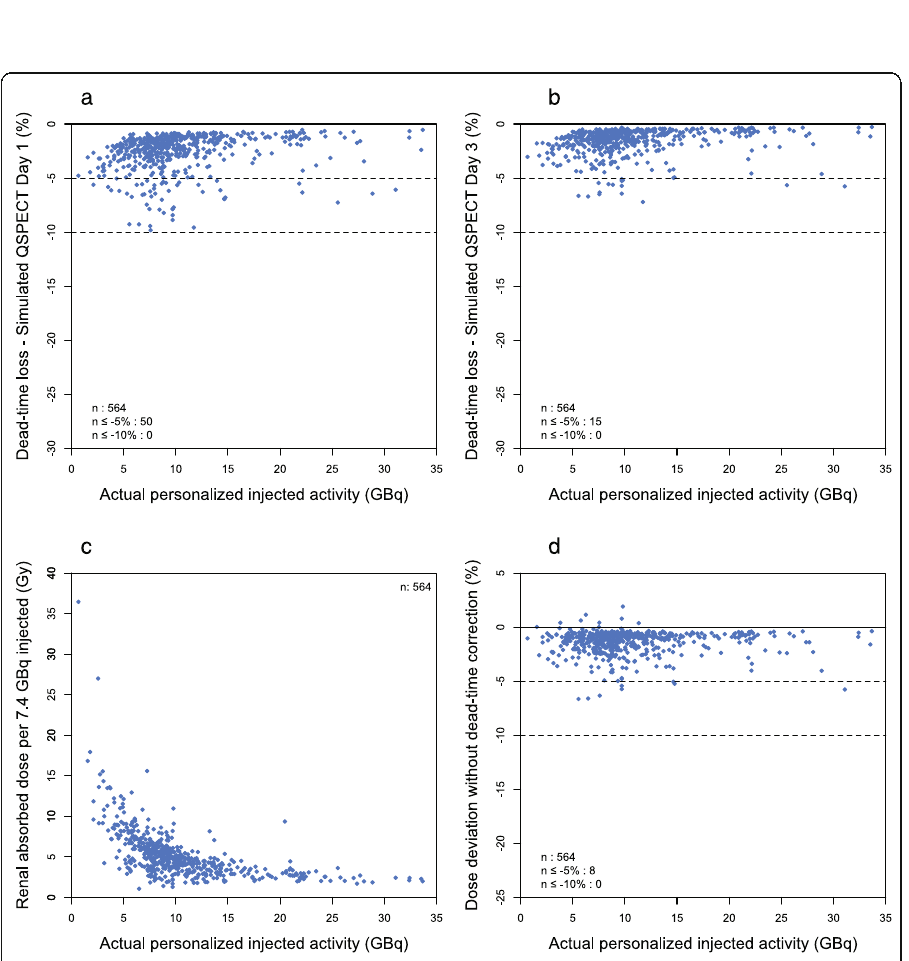
Fig. 4 Dead time and dosimetry in simulated empiric PRRT (7.4 GBq/cycle). The dead-time count loss affecting day 1 ( a ) and day 3 ( b ) QSPECT scans, the renal absorbed dose ( c ) and its deviation without dead- time correction ( d ) are plotted against the actual personalized injected